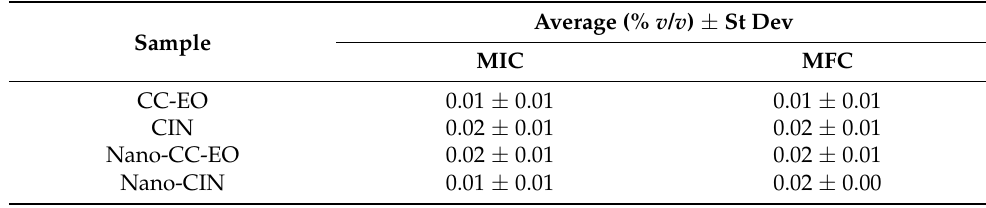
Table 4. MIC90 and MBC90 values of the three fractions and nano-formulation obtained from CC-EO against ten C. auris